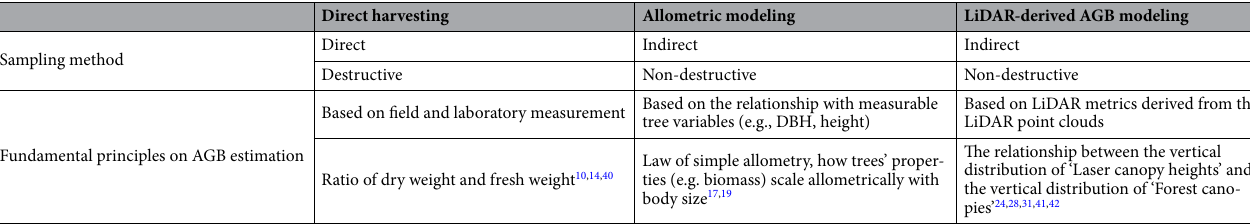
Table 1. Comparison table on the common AGB estimation